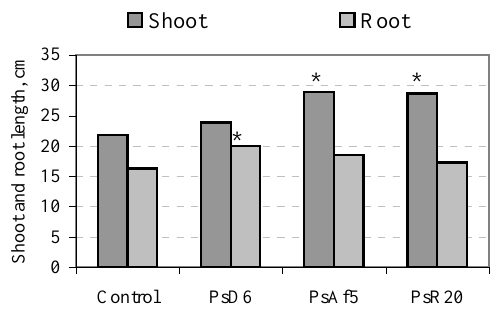
FIGURE 2 . Effect of Pseudomonas spp. on shoot and root growth of maize, P. denitrificans PsD6, P. aureofaciens PsAf5, and P. rathonis PsR20. *Significant differences, p < 0.05.